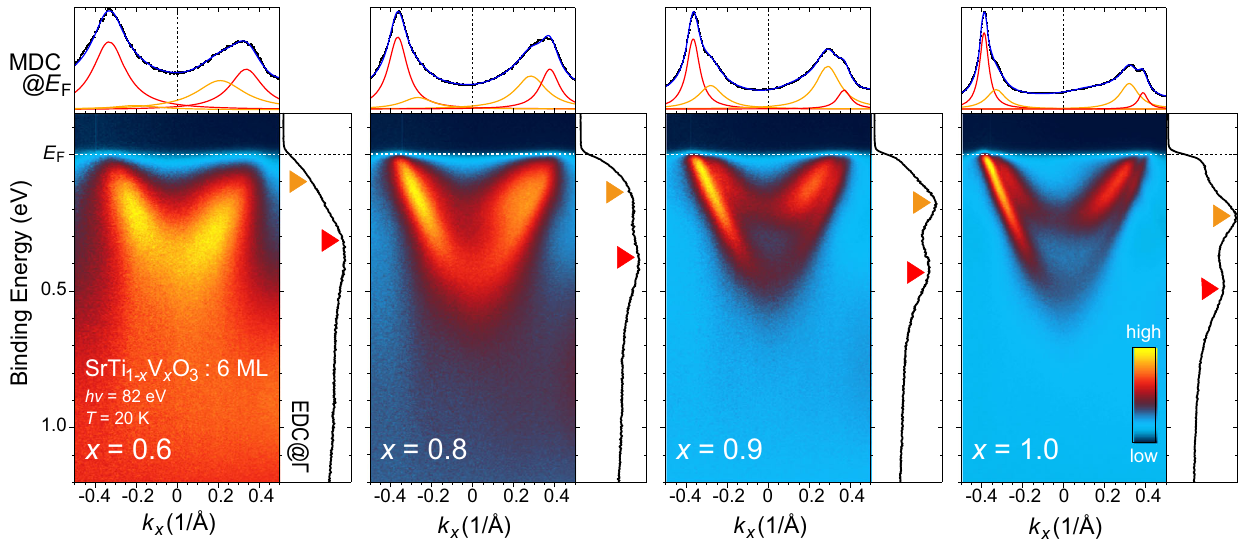
Fig. 1 In situ ARPES intensity plot along the Γ – X direction for STVO QW structures with x = 0.6 – 1.0. The MDCs at E F with an energy window of ±25 meV are shown in the respective ARPES images (top panel), while EDCs at the Γ point [along the center line ( k x = 0)] are on the right-hand side of each image. The intensity of n = 1 and n = 2 is reversed on the left- and right-hand sides with respect to the centerline owing to pronounced matrix-element effects. The red and orange arrows in the EDCs indicate the n = 1 and n = 2 quantization energies (bottom energies of subbands), respectively. In the MDCs, the fi tting results for n = 1, n = 2, and total are overlaid by red, orange, and blue curves, respectively (see Supplementary Fig. 6). It should be noted that the ARPES images consist of only the d zx bands of V 3 d t 2g states in the present experimental geometry (see Supplementary Note 2) owing to the dipole selection rules for the light polarizations and each orbital symmetry with respect to the mirror plane 41